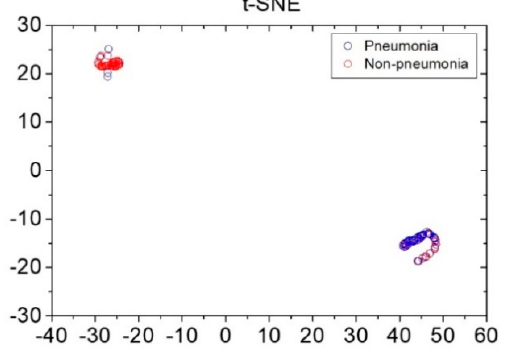
Figure 4. Distribution of pneumonia and non-pneumonia data clusters using the t-stochastic neighbor-embedding visualization technique. x and y axes represent dimensions 1 and 2, respectively, derived using the t-stochastic neighbor-embedding algorithm.